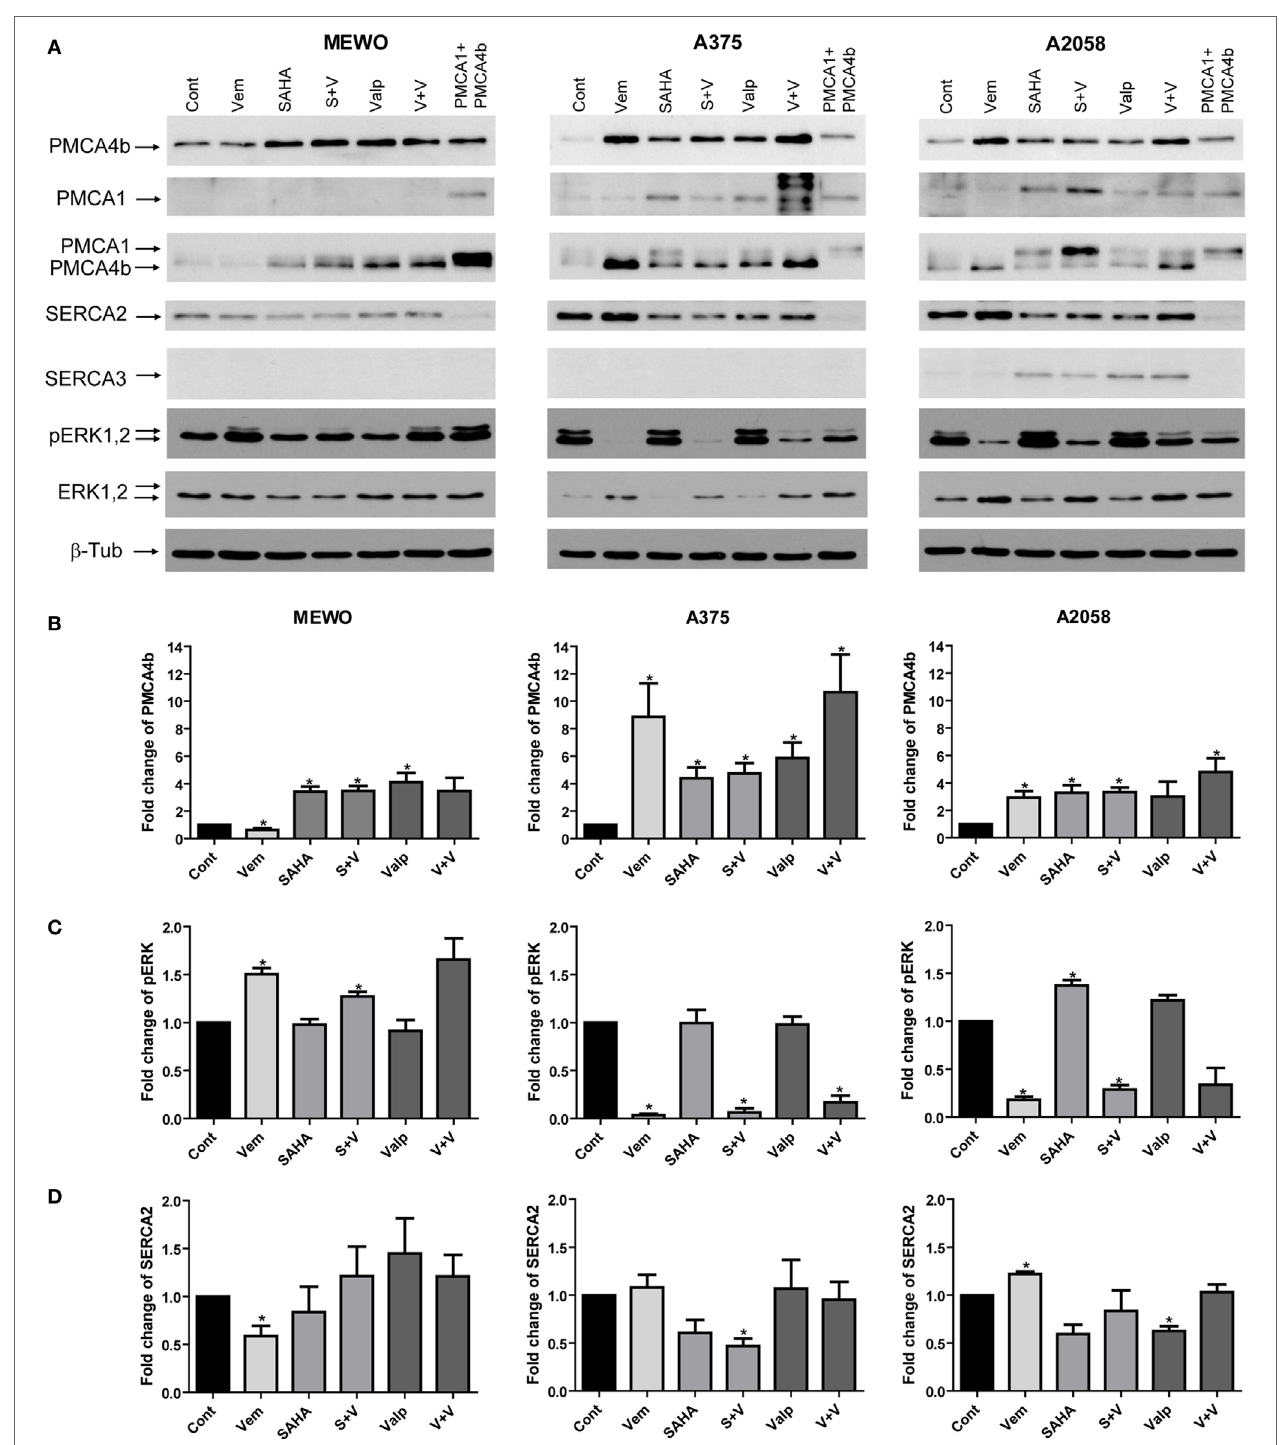
FigUre 2 | combination treatment with the mutant BraF inhibitor vemurafenib and histone deacetylase inhibitors (hDaci) . BRAF wild-type MEWO and BRAF-mutant A375 and A2058 cells were treated with the mutant BRAF inhibitor vemurafenib (0.5 µM), HDACi SAHA (1 µM), and valproate (2 mM) alone or in combination for 48 h. After Western blotting expression of PMCA4b, PMCA1, SERCA2, SERCA3, pERK, and ERK proteins were analyzed. As a positive control of PMCA1 and PMCA4b, total cell lysate of COS-7 cells was used, which endogenously express both proteins (9). (a) The expression of PMCA proteins was detected with isoform-specific and pan-PMCA antibodies. (B) After densitometric analysis, changes in PMCA4b (B) , ERK (c) and SERCA2 (D) protein levels were normalized to the expression levels of β -tubulin and expressed as fold increase over the untreated controls. Bars represent mean ± SE from three independent experiments. Significance compared to control is denoted by asterisks (* p < 0.05), using two-tailed paired t